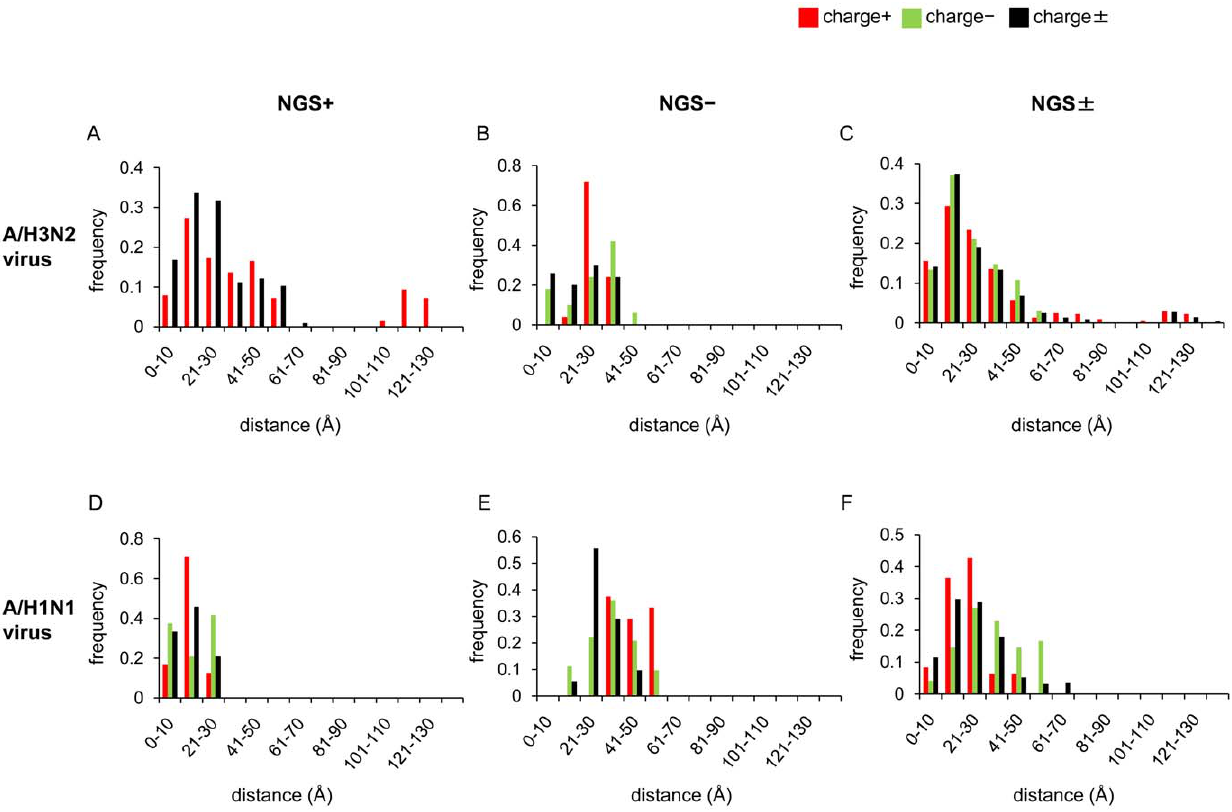
Figure 3. Distribution of distances from RBP to amino acid substitutions. The distances in the three-dimensional structure of HA were measured between RBP and amino acid substitutions occurring on the NGS + (A and D), NGS 2 (B and E), and NGS 6 (C and F) trunk branches for A/ H3N2 (A-C) and A/H1N1 (D-F) viruses.